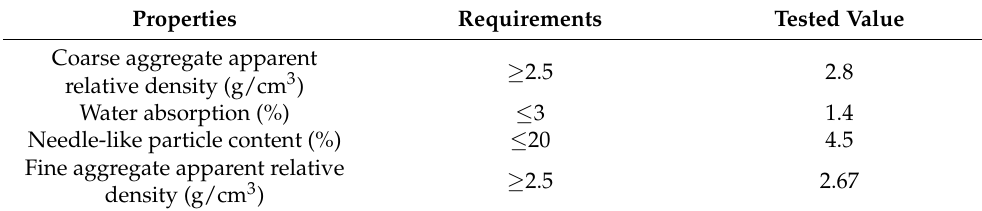
Table 2. Properties of aggregates.